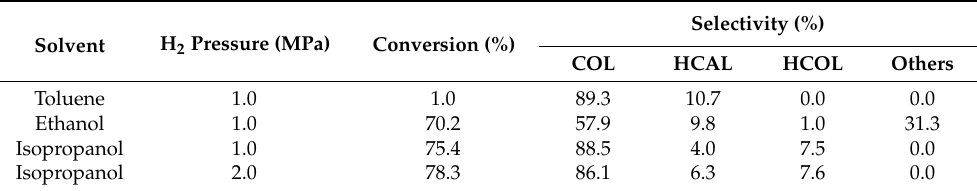
Table 5. Effect of solvent and hydrogen pressure on the hydrogenation of cinnamaldehyde over Au/Zn 0.7 Fe 0.3 O x .